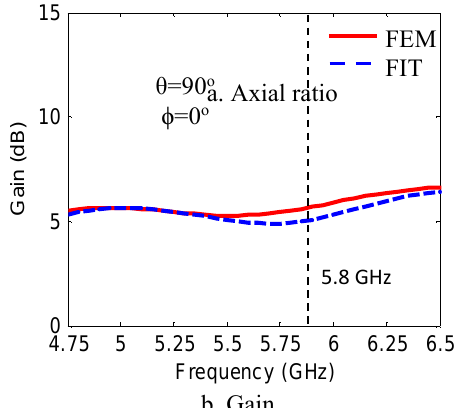
polarized DRA element mounted on a cylindrical ground plane in free